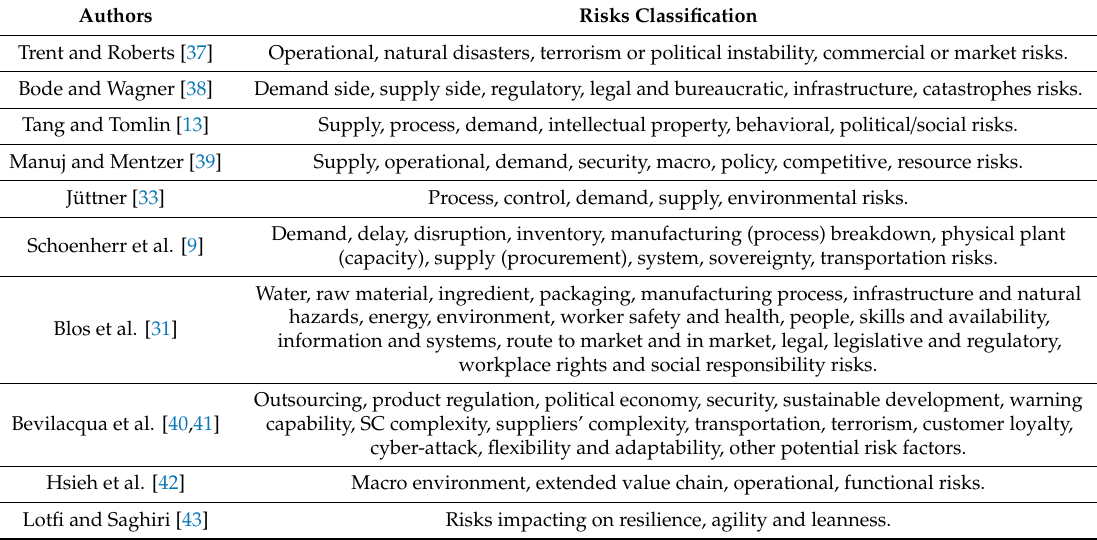
Table 1. Literature review on supply chain risks